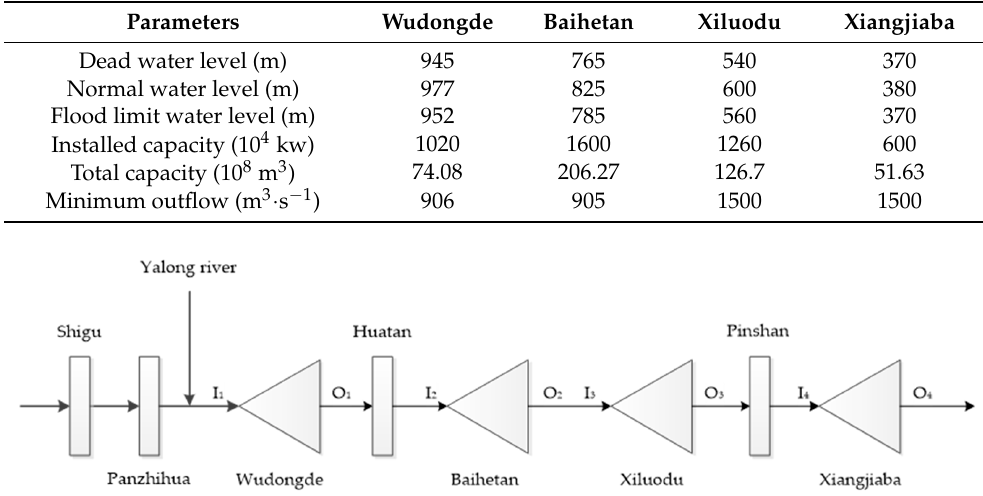
Figure 12. Locations of major cities and hydrological stations along the Jinsha River. Table 1. Main parameters of the four cascade hydropower stations along the lower reaches of the Jinsha River.